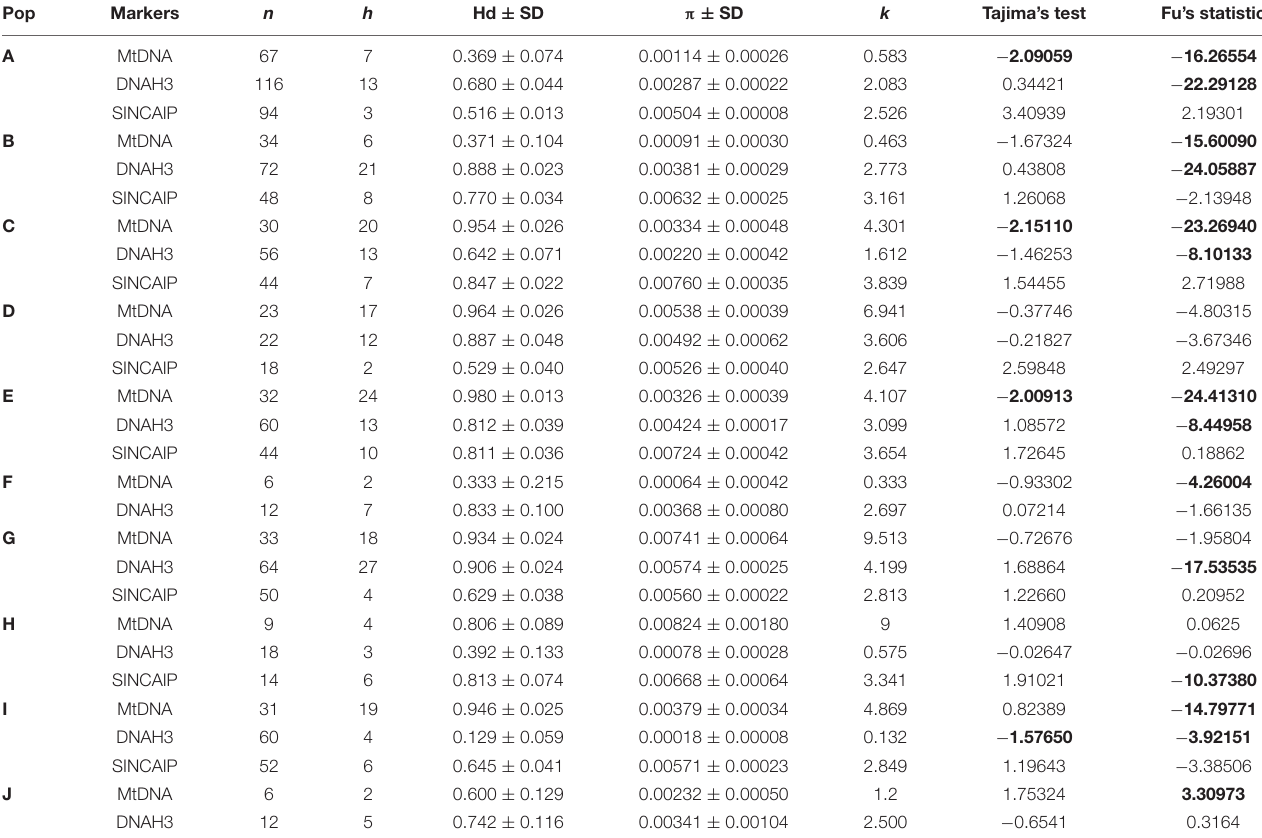
TABLE 2 | Genetic parameters calculated for K. calcarata populations.